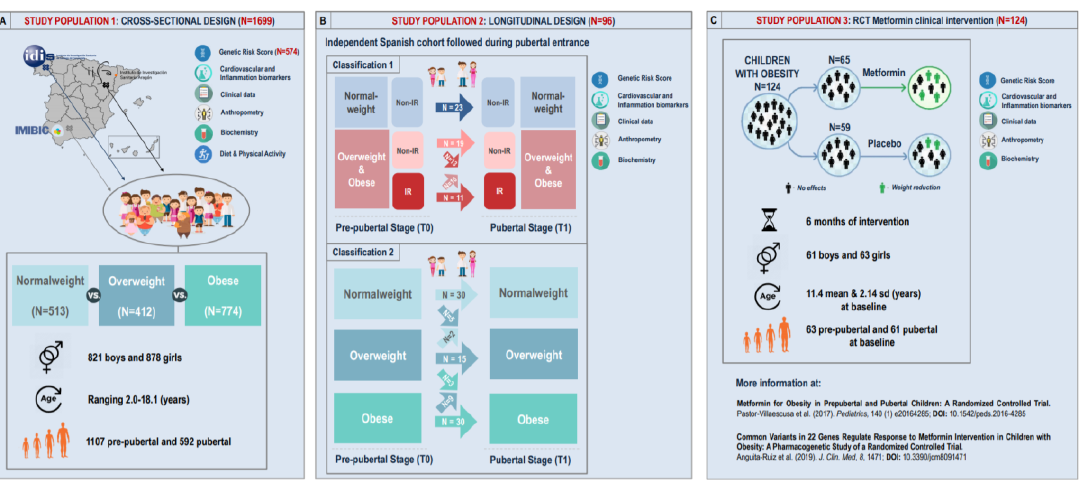
Figure 1. General description of study populations and design. ( A ) General characteristics of study population 1, which is based on a previously conducted case-control multicentre cross-sectional design. ( B ) General characteristics of study population 2, which is based on a previously conducted longitudinal design on 96 children undergoing puberty. ( C ) General characteristics of study population 3, which corresponds to a previous multicentre and double blind randomized controlled trial (RCT) conducted in 124 children with obesity.